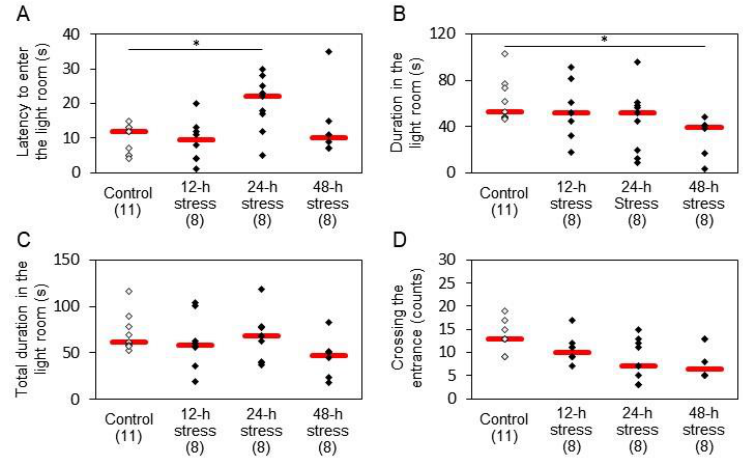
Figure 3. Effects of water immersion stress on rat anxiety-related behavior in the light/dark box test. ( A ) Latency to enter the light room; ( B ) duration in the light room; ( C ) total duration in the light room; ( D ) crossing the entrance. Red bars represent the median. Parenthesis: the number of animals. * p < 0.05 by Steel − Dwass test. Stress for 24 h caused an increase in the latency to enter the light room, and 48 h stress reduced the time spent in the light room, both of which were statistically significant.